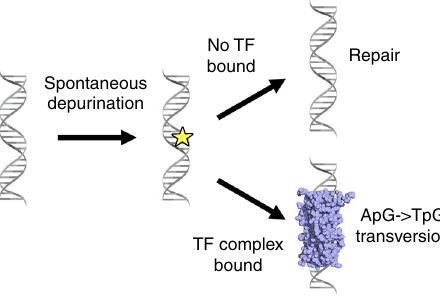
Fig. 6 Proposed mechanism of faulty repair at abasic